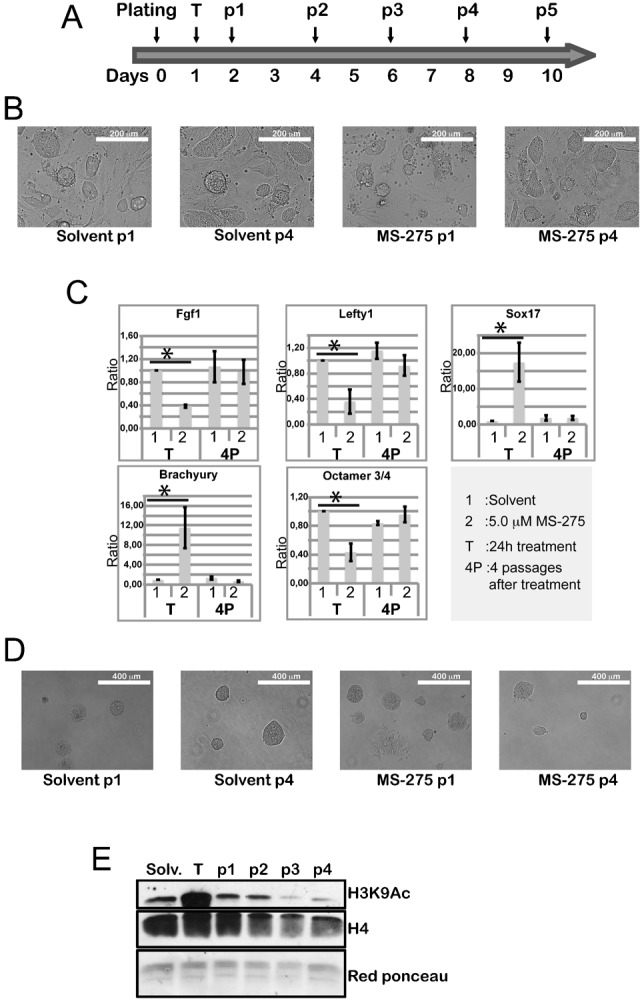
Reversible effect of MS-275 on ESCs.(A) Schematic representation of the experiment: T  =  treatment of 24 h with 5.0 µM MS-275; p1–p4: days of medium change and photo collection. (B) Photo in bright field of solvent and drug treatment at p1, p4. (C) q-PCR of solvent and MS-275 at 5.0 µM concentration treated cells at p1 and p4 for the indicated markers; *p<0.01. (D) Colony formation assay for each day and treatment. (E) H3K9 Acetylation (Ac) levels after 24 h of treatment with MS-275 at 5.0 µM and at the different passages (p1, p2, p3 and p4). Scale bars: 200 µm (B), 400 µm (D).